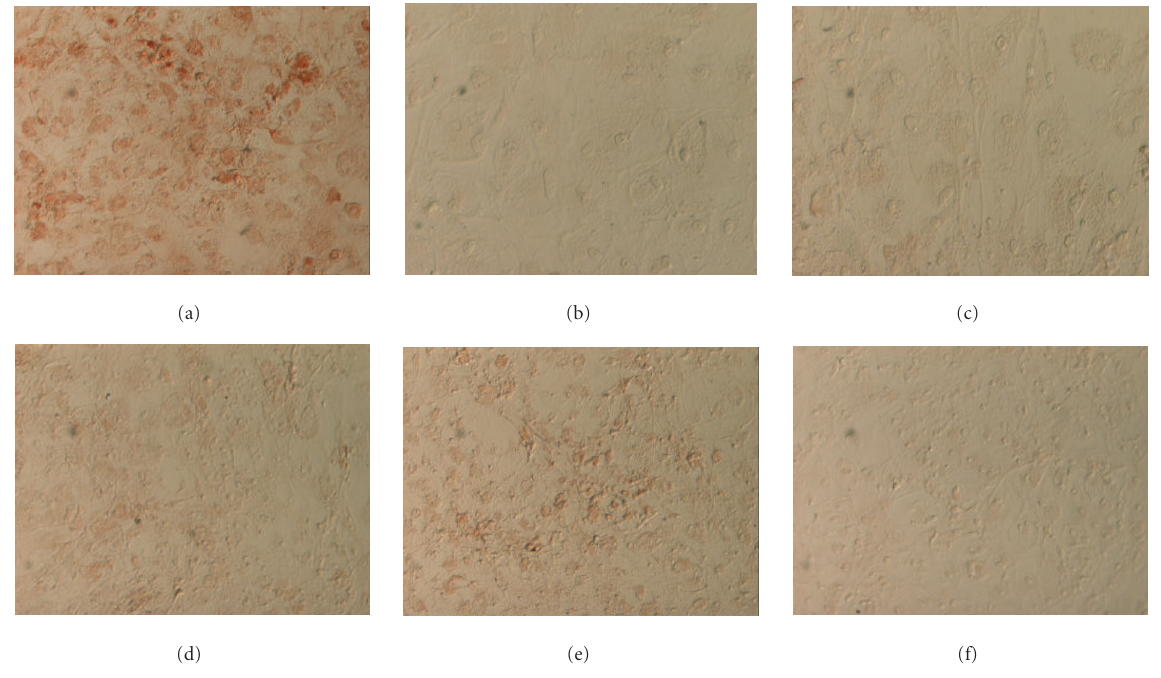
Figure 5. Identification of p53 as a biochemical marker of apoptosis. (a) Cells filtered: 11% of the total cells counted (450) were positive. (b) In cells not filtered the apoptotic range was 97.5% positive and 2.5% negative. (c) Addition of crude matrix extract revealed weak or no labelling. (d), (e) Cultures with sugar extract and hyaluronan addition showed a value of 8% for positive cells. (f) The addition of large, medium, and small proteins results were very similar to those of not filtered cultures (3% positive).